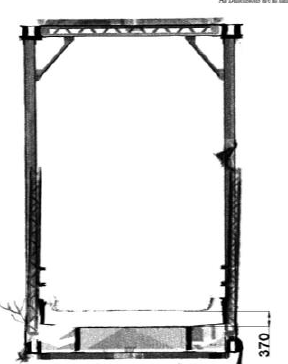
Figure 9: Truss bridge deck linearity deflection graph The maximum Truss Bridge deck linearity deflection obtained is 112.23 mm shown in red.